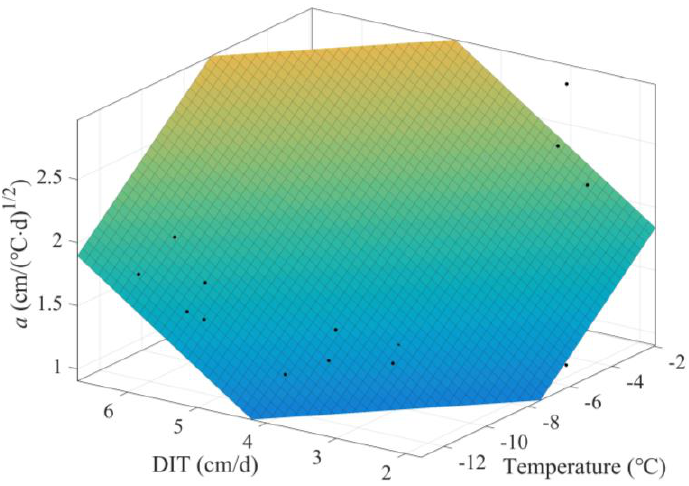
Figure 6. The freezing rate varies with DIT and temperature.